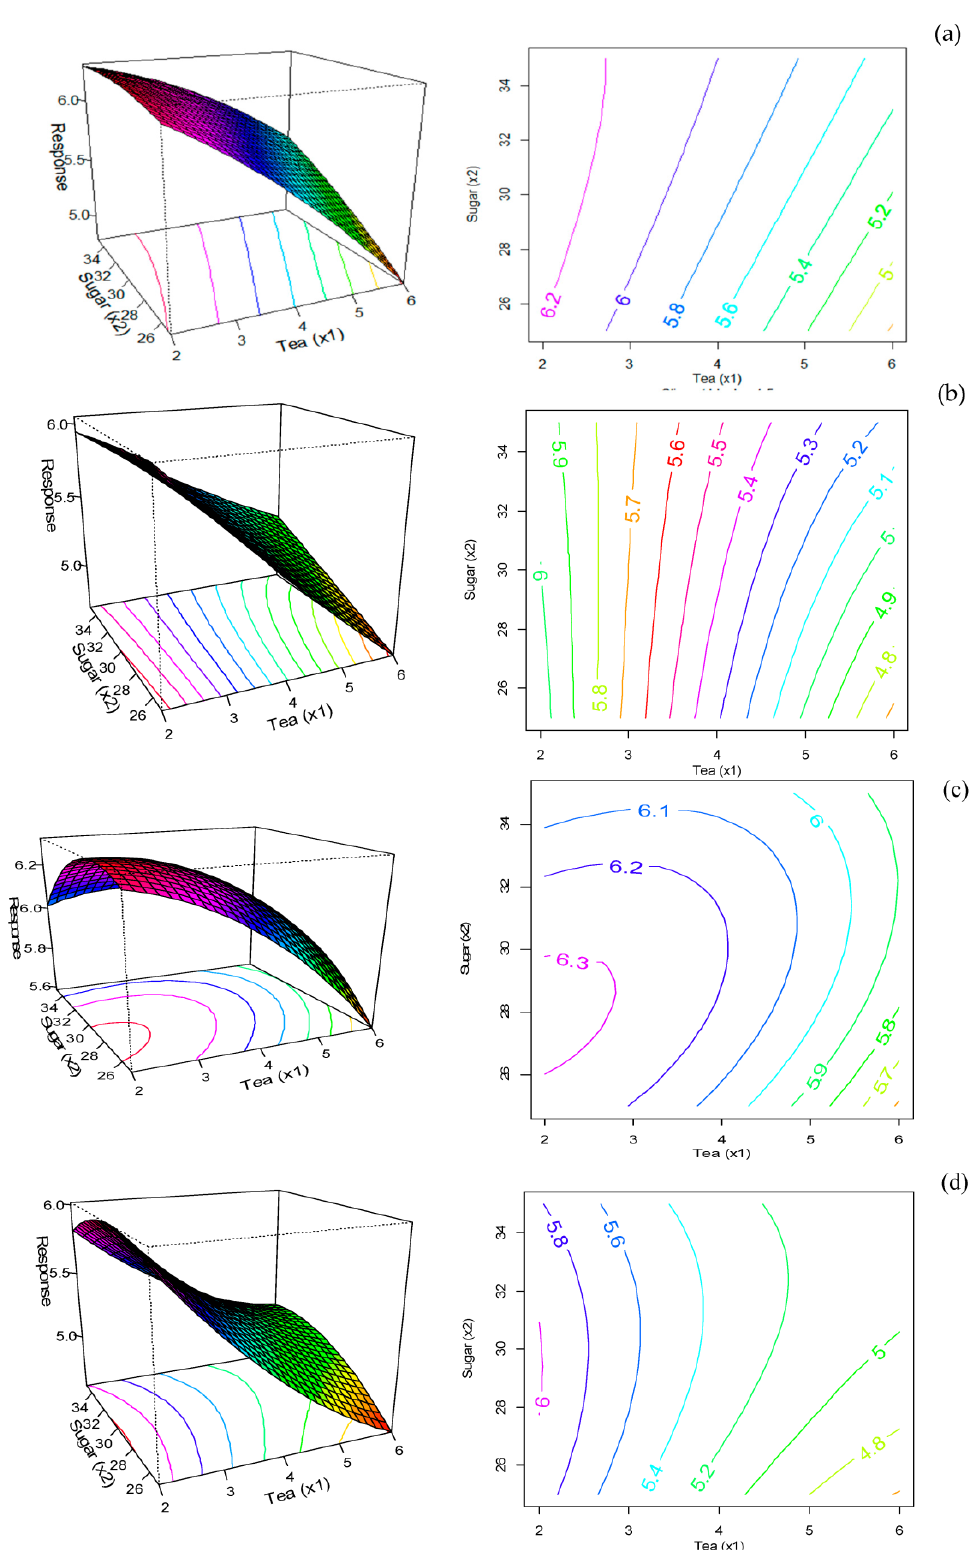
Figure 3. Response surfaces and contour plots of the effect of MGTP and sugar content incorporated ( a ) overall, ( b ) appearance, ( c ) aroma, and ( d ) color acceptability of biscuits.